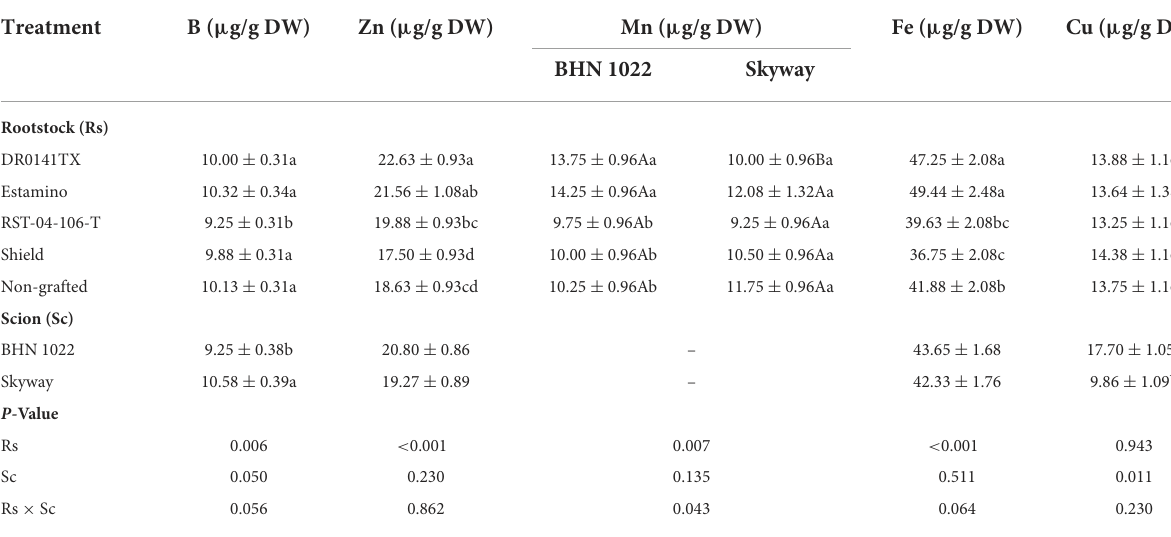
TABLE 9 Fruit micronutrient content on a dry weight basis in grafted tomatoes as affected by rootstock and scion cultivars in the spring planting (14 February to 18 June 2020).